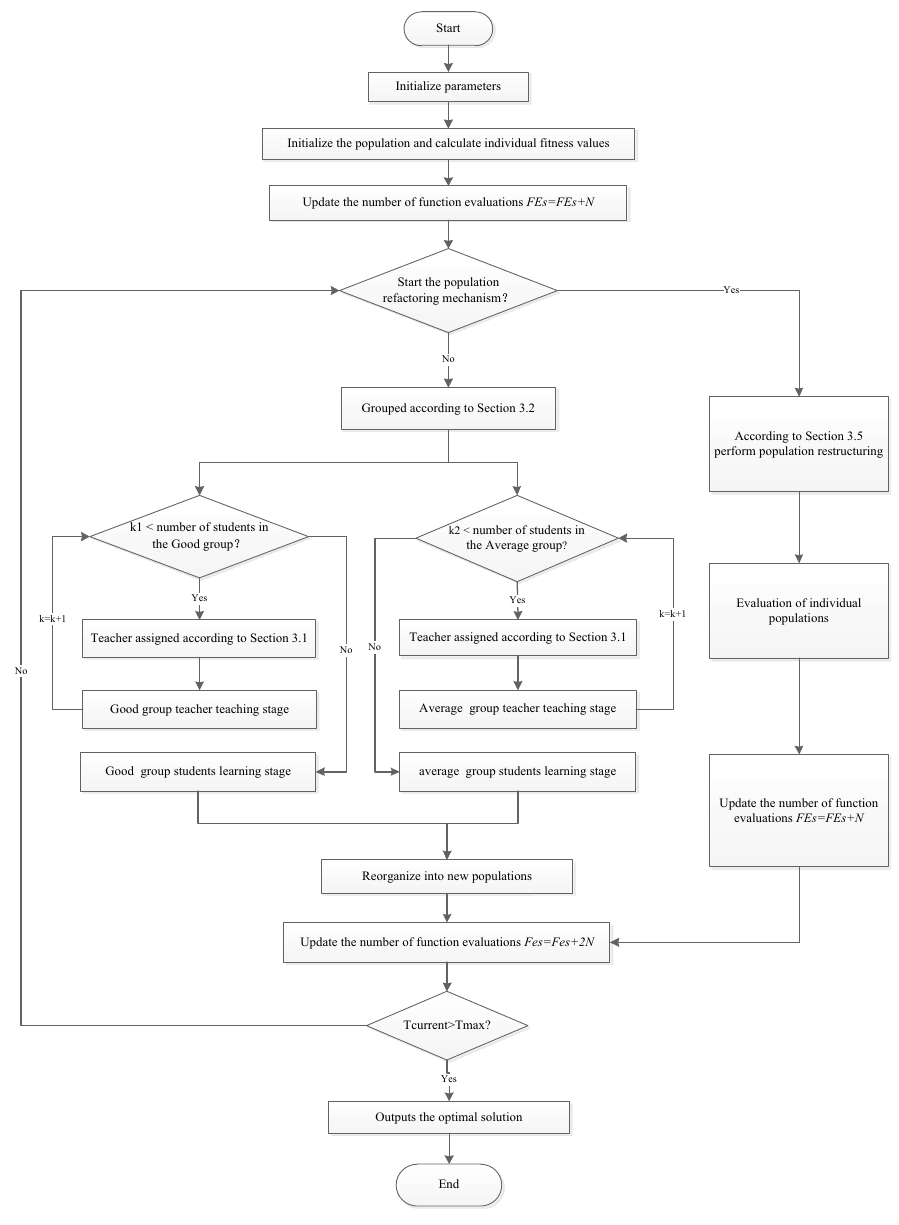
Figure 1. IGTOA flow